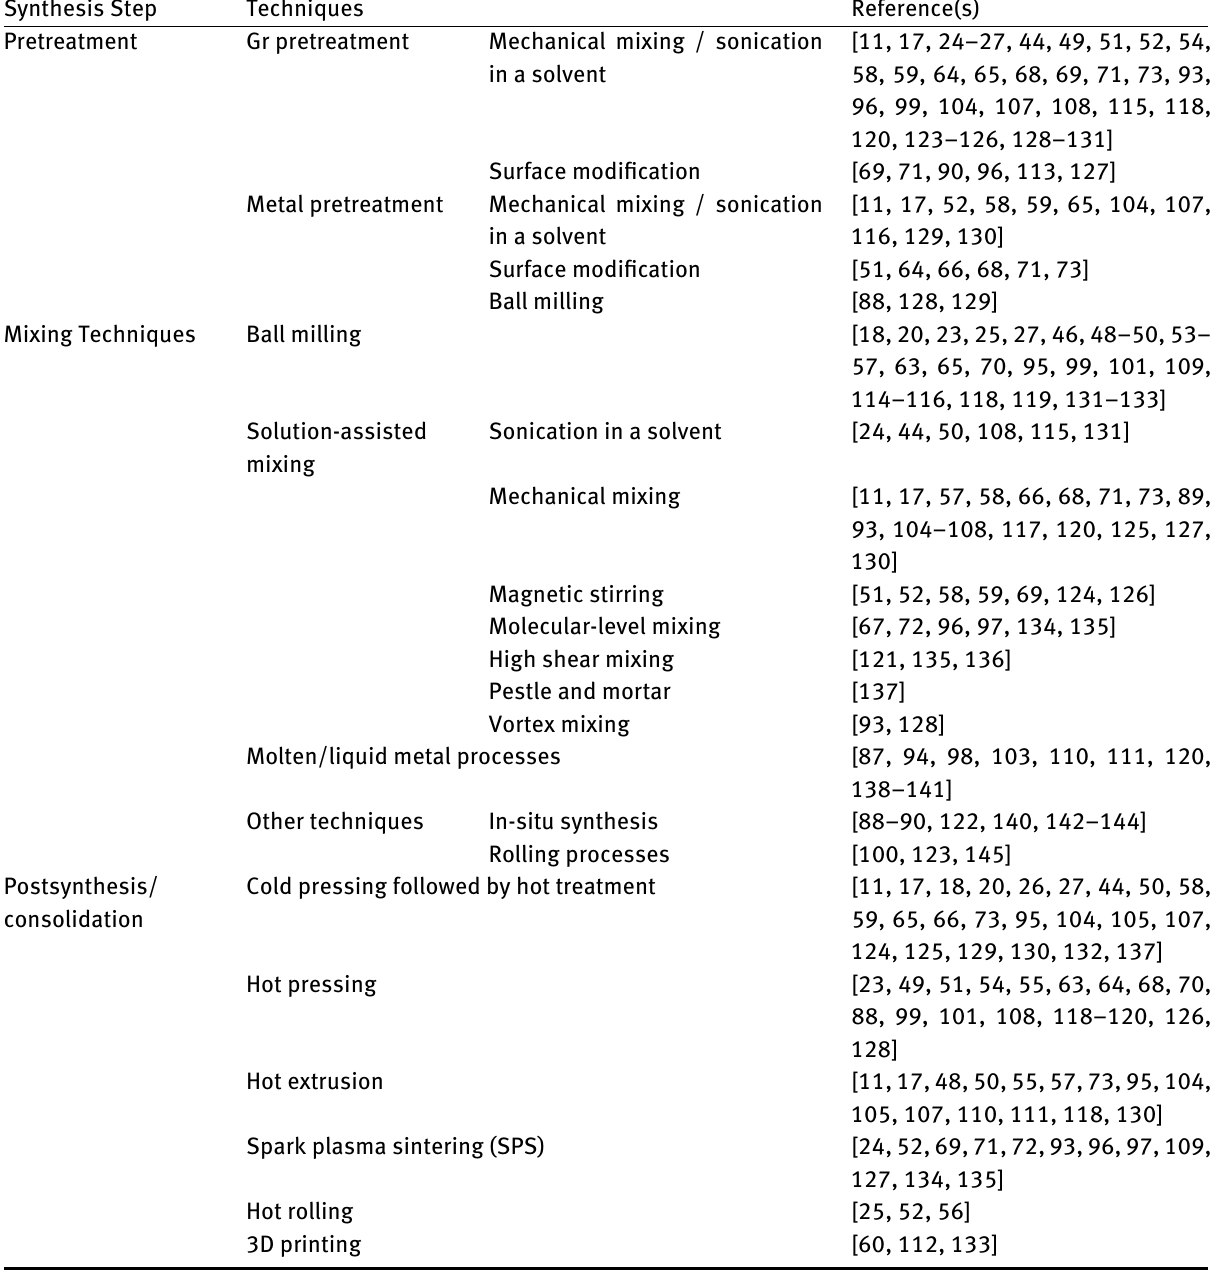
Table 3: Summary of Synthesis Techniques Used for the Fabrication of